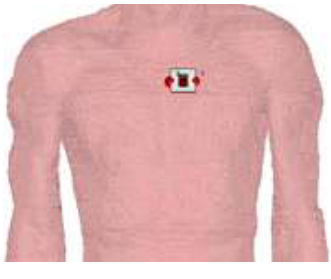
Figure 16. Layout configuration of the simulation of the device in contact with the body.